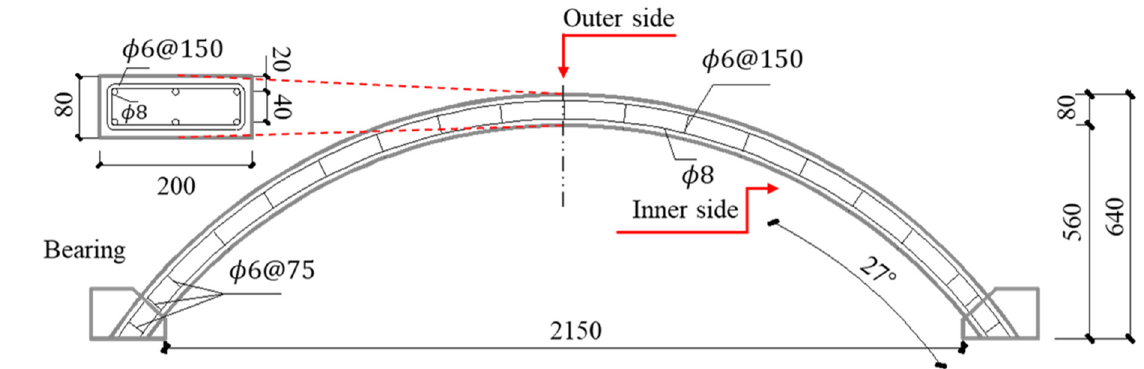
Figure 1. Reinforced concrete arch structure (mm). Table 1. Physical properties of concrete, steel and polyurea.